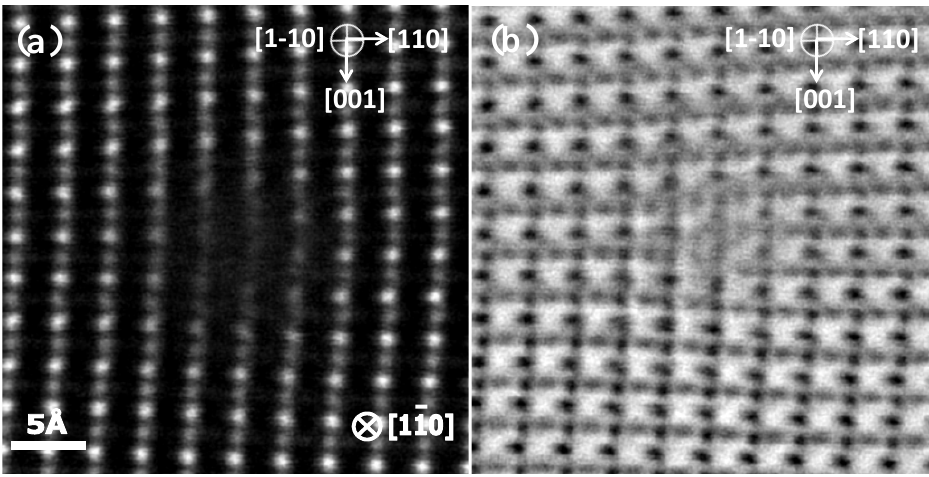
Figure 26. ( a ) Atomic-resolution HAADF STEM image of the dislocation viewed from the [110] direction, and ( b ) the corresponding ABF STEM image obtained simultaneously with the HAADF STEM image [32].